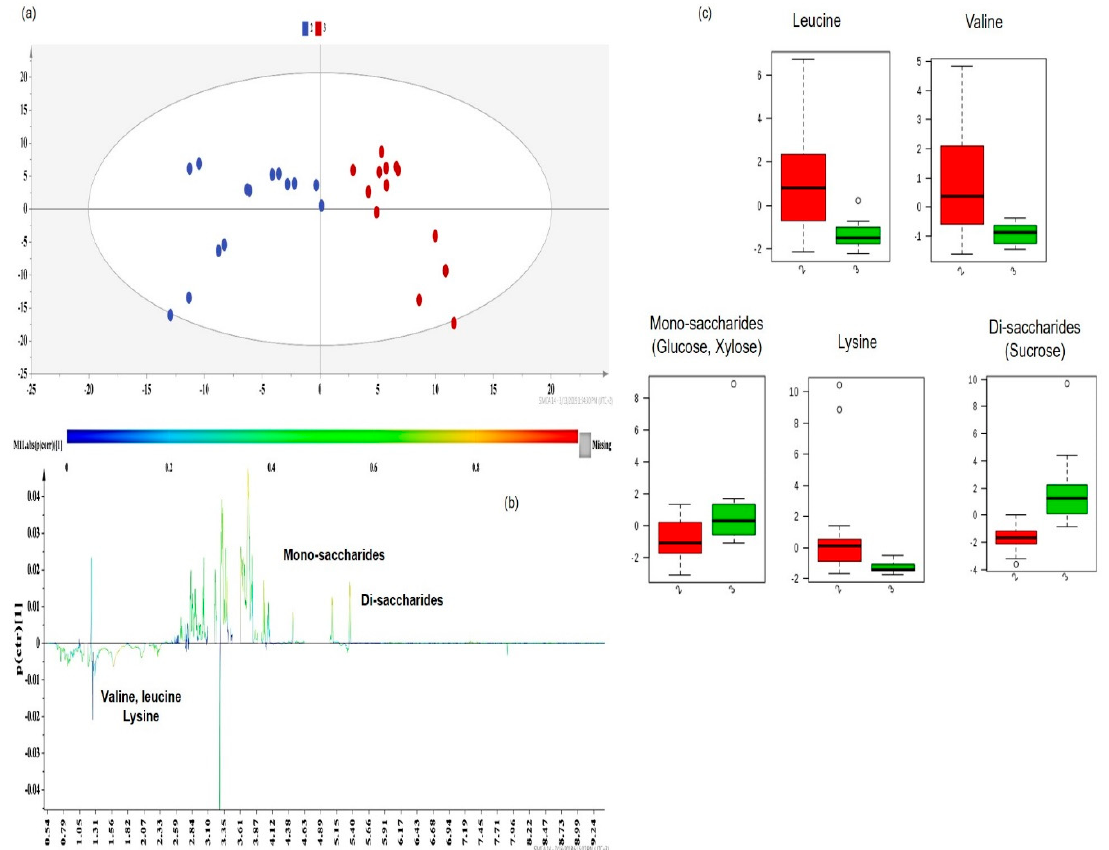
Figure 11. ( a ) OPLS-DA model of Group 2 vs. Group 3 DOE apricot extracts, Pareto scaled, where A = 1 + 1 (N = 27, R 2 Y(cum) = 0.780, Q 2 (cum) = 0.642, p < 0.05), blue dots = apricot pulp samples with a low extraction yield (5–15 mg carotenoids 100 g − 1 dry sample), and red dots = apricot pulp samples with a medium extraction yield ( ≥ 15 mg carotenoids 100 g − 1 dry sample); ( b ) S-line plot of the OPLS-DA model; ( c ) box-plots of the discriminant metabolites, where red box-plots correspond to Group 2 (blue dots) and green box-plots correspond to Group 3 (red dots).